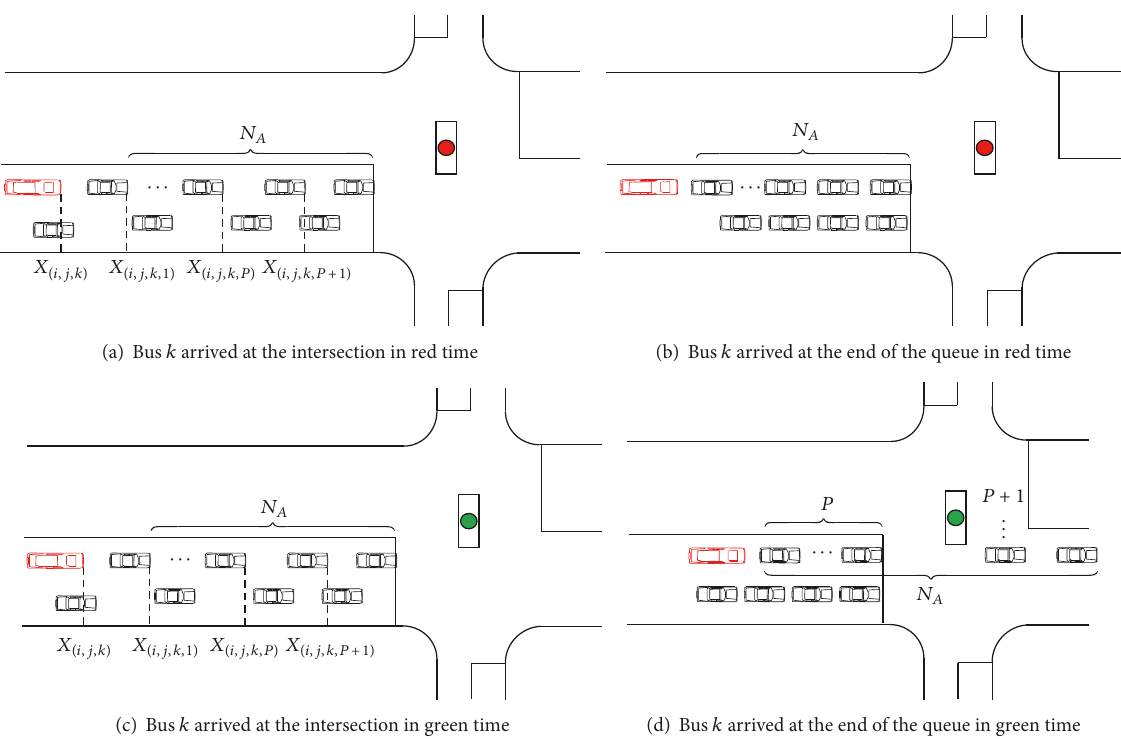
Figure 5: Four situations for bus 𝐾 getting to the stop